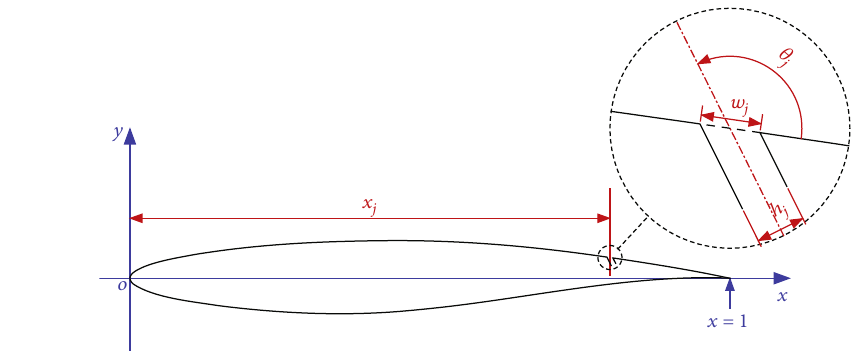
Figure 2: De fi nition of the jet geometric parameters.